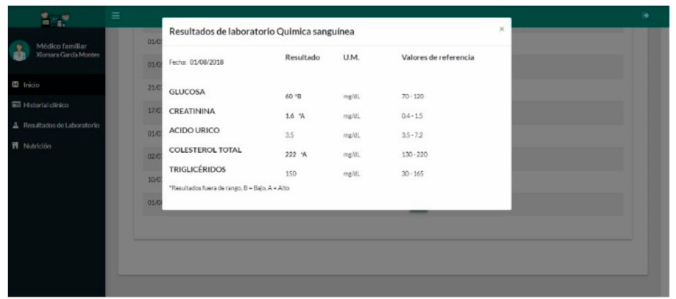
Figure 25. Physician application interface: Eating pattern assigned to the patient.